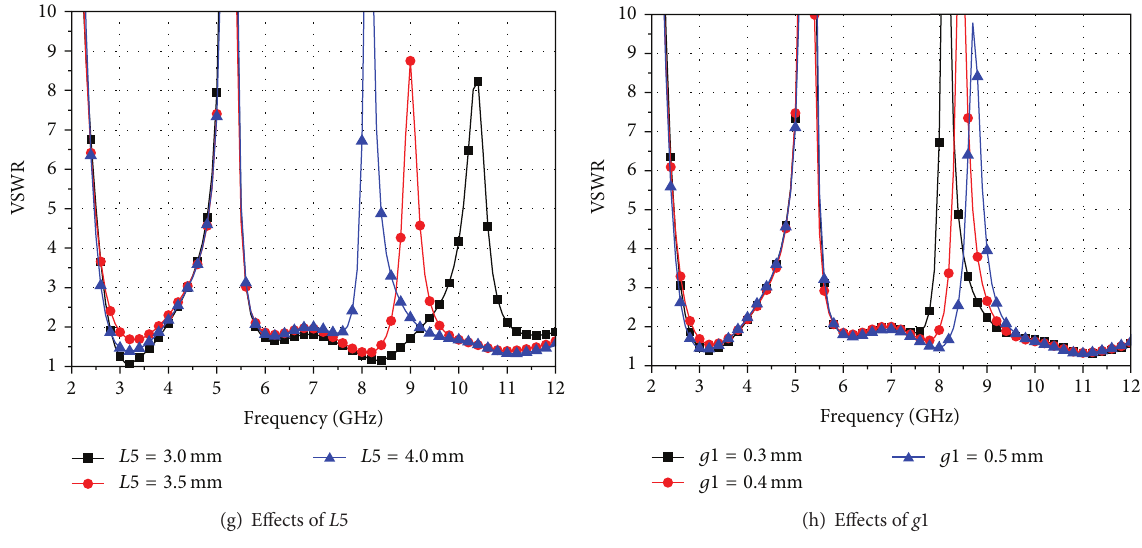
Figure 3: Parametric effects of antenna-4 with all switches ON.